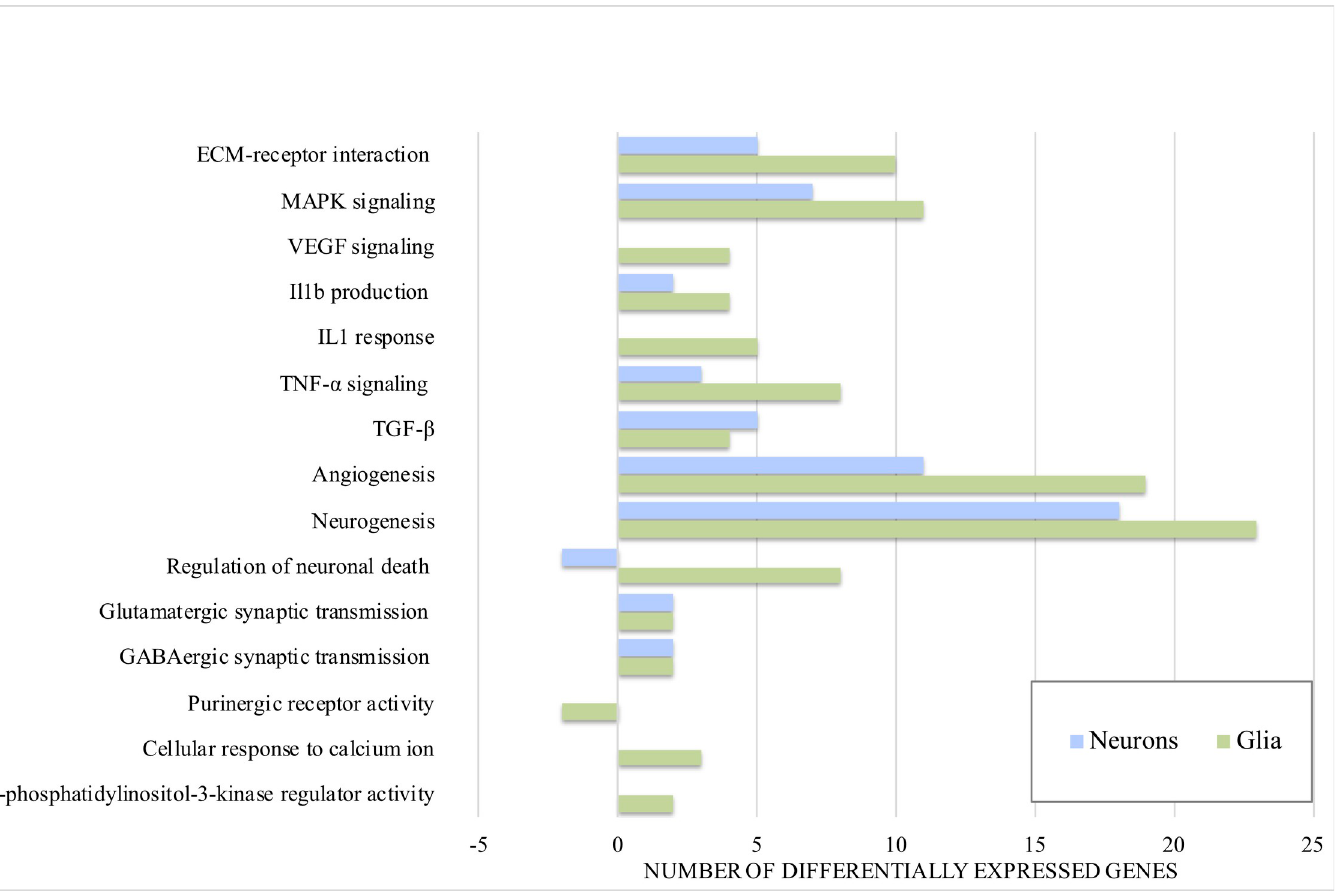
Fig 2. Number of up- and downregulated neuronal and glial genes within epilepsy-relevant functional annotation terms (GO / KEGG). Neuronal and glial contribution to epilepsy-relevant GO / KEGG pathways (p < 0.05) amongst differentially expressed genes. Negative values indicate downregulated genes, positive values upregulated